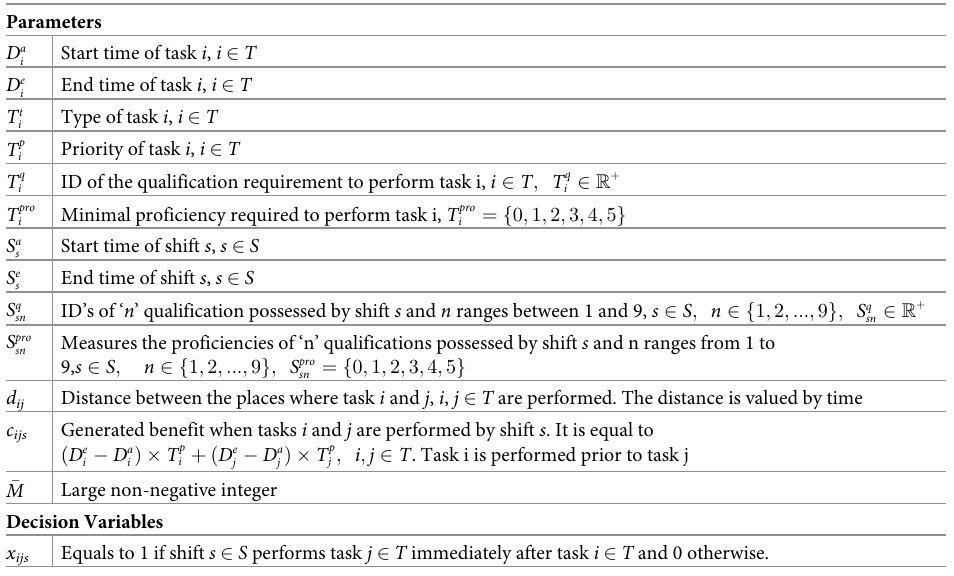
Table 3. Notations.